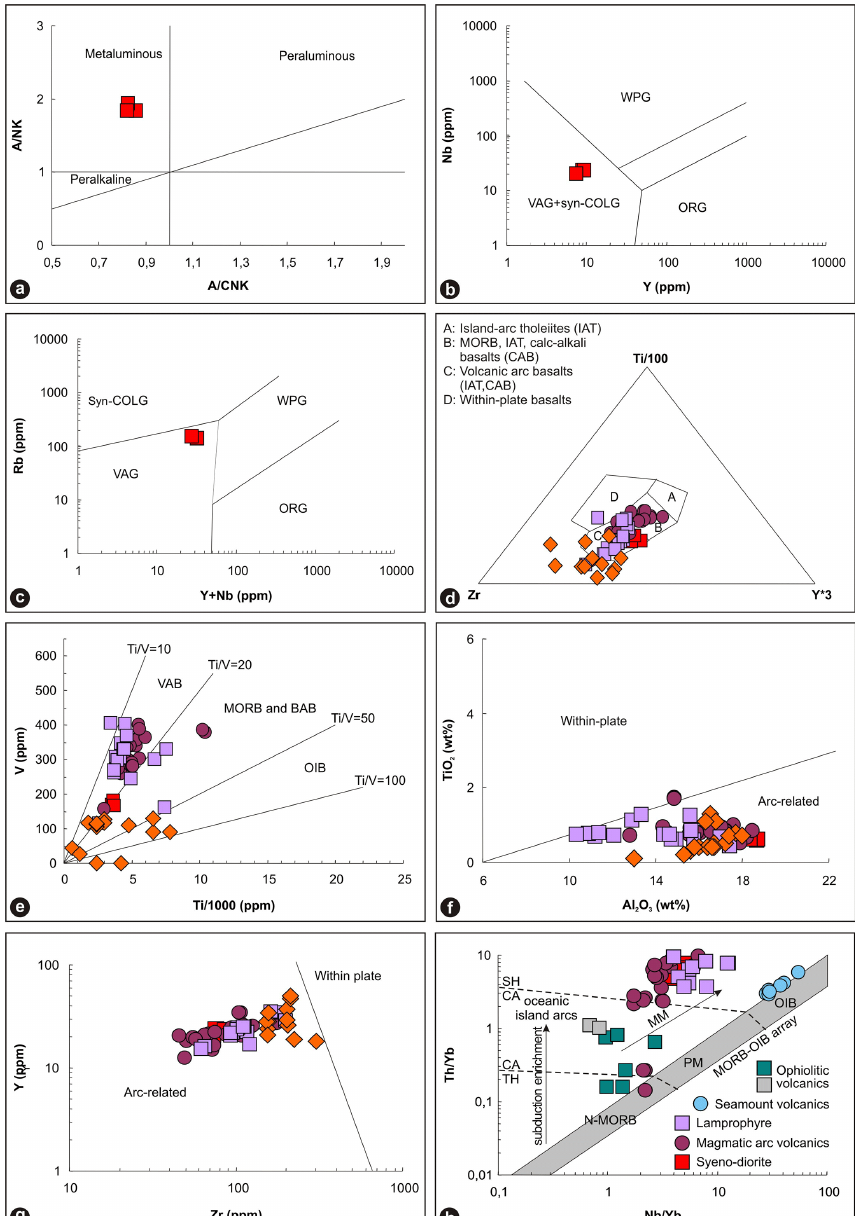
Fig. 16. (a) A/CNK, molar Al 2 O 3 /(CaO + Na 2 O + K 2 O) vs. A/NK, molar Al 2 O 3 /(Na 2 O + K 2 O) diagram (Shand, 1927). (b, c) trace element discrimination diagrams (Nb–Y and Rb vs. Y + Nb) for syenodioritic pluton rocks (fields from Pearce et al., 1984; VAG = volcanic arc granites, WPG = within-plate granites, ORG = ocean ridge granites. SYN-COLG = syn-collisional granites. (d) Ti–Zr–Y diagram. (e) Ti–V diagram. (f) TiO 2 vs. Al 2 O 3 diagram. (g) Y vs. Zr diagram. (h) Th/Yb vs. Nb/Yb diagram (fields after Pearce and Cann, 1973; Shervais, 1982; Muller et al., 1992; Pearce,